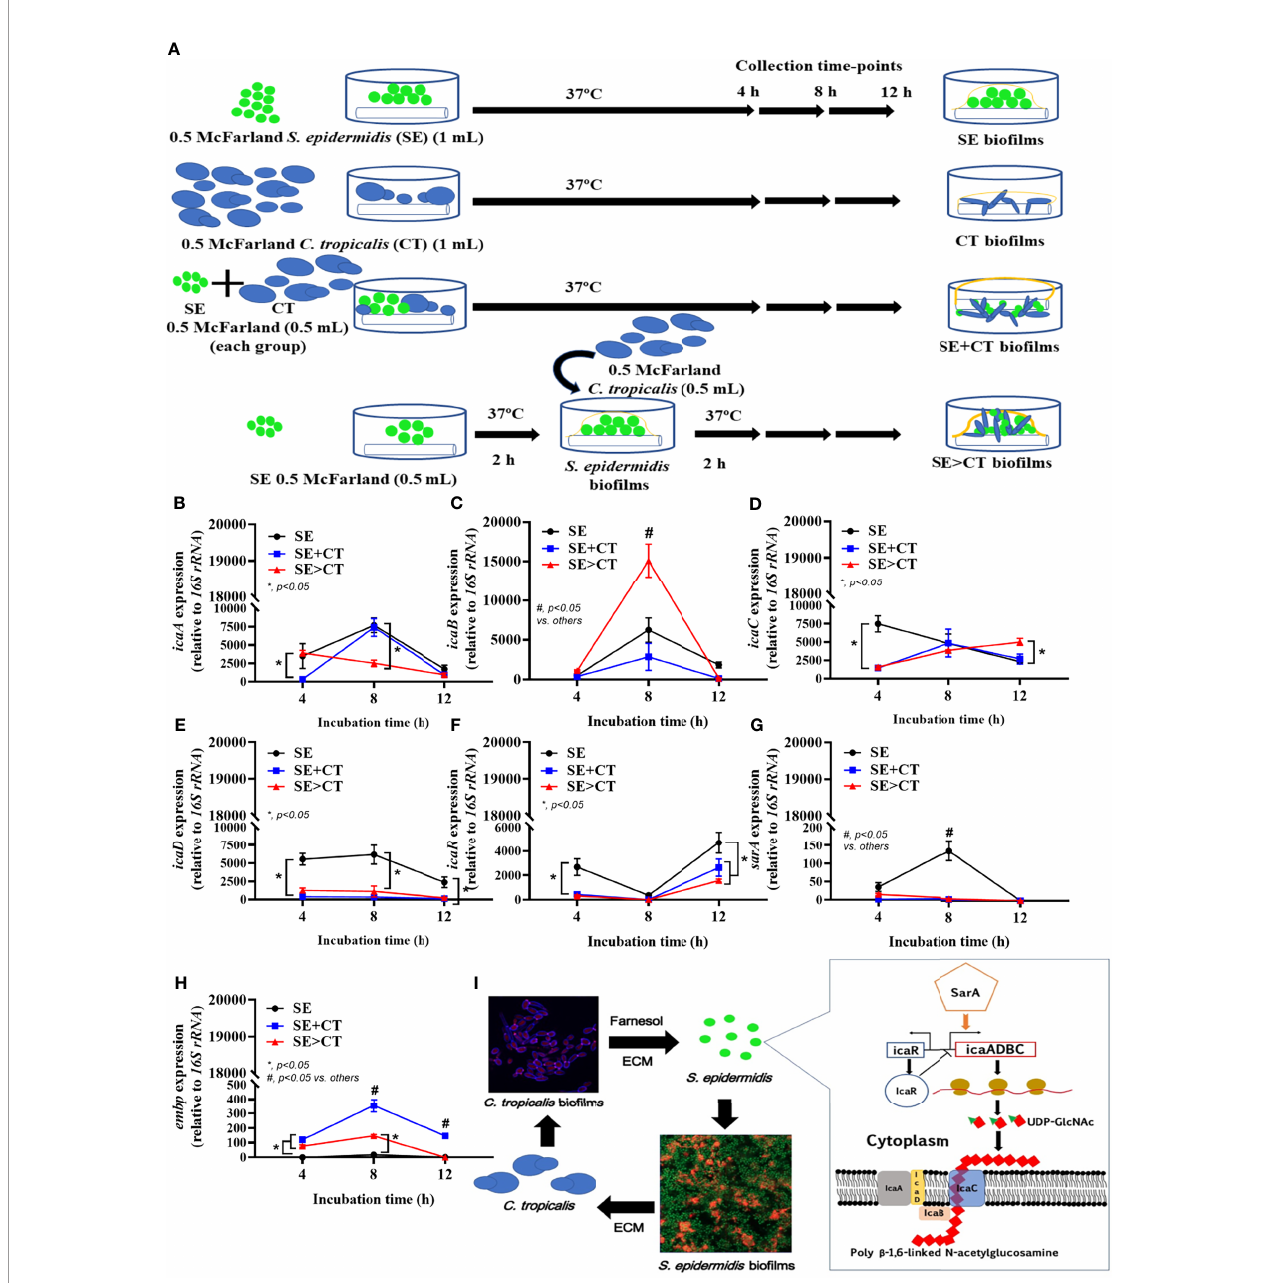
FIGURE 4 | The representative pictures of bio fi lm thickness by the lateral view of z-stack fl uorescent stained pictures from clinically isolated Staphylococcus epidermidis (SE) and Candida tropicalis (CT) mixing (SE + CT) (left side) and SE before CT (SE > CT) (right side), indicating bacterial nucleic acid (SYTO9; green color fl uorescence), extracellular matrix (wheat germ agglutinin (WAG)-AF647; red color fl uorescence), and fungal cell wall (CW2MR; blue-purple color fl uorescence) (A) are shown. Expression of SE bio fi lm-associated genes from cover-glass bio fi lms of clinically isolated SE (SE), Candida tropicalis (CT), SE simultaneously mixed with CT (SE + CT), and preformed SE bio fi lms following by CT (SE > CT) in different time-points (B – G) are demonstrated (independent triplicate experiments were performed). Diagram of the possible linkage between CT and SE bio fi lm synthesis indicates that Candida -producing farnesol, a quorum-sensing molecule blocking the yeast-to- fi lament conversion in fungal bio fi lms (Carolus et al., 2019), stimulates SE bio fi lm synthesis through the upregulated sarA and downregulated icaR (as demonstrated in the pathway) (Bresco ́ et al., 2017) (H) . Notably, icaA and icaD are responsible for UDP-Glc-NAc [uridine diphosphate N -acetylglucosamine, a single unit of the polysaccharide intercellular adhesin (PIA) in extracellular matrix (ECM)], while icaB and icaC are used for polymerization and transportation of ECM, respectively (Arciola et al., 2015) and the possible association with Candida (I) . Meanwhile, embp expression increases bacterial adhesive protein of ECM. The results were from three independent experiments in triplicate as the mean ± SEM; p < 0.05 was considered statistically signi fi